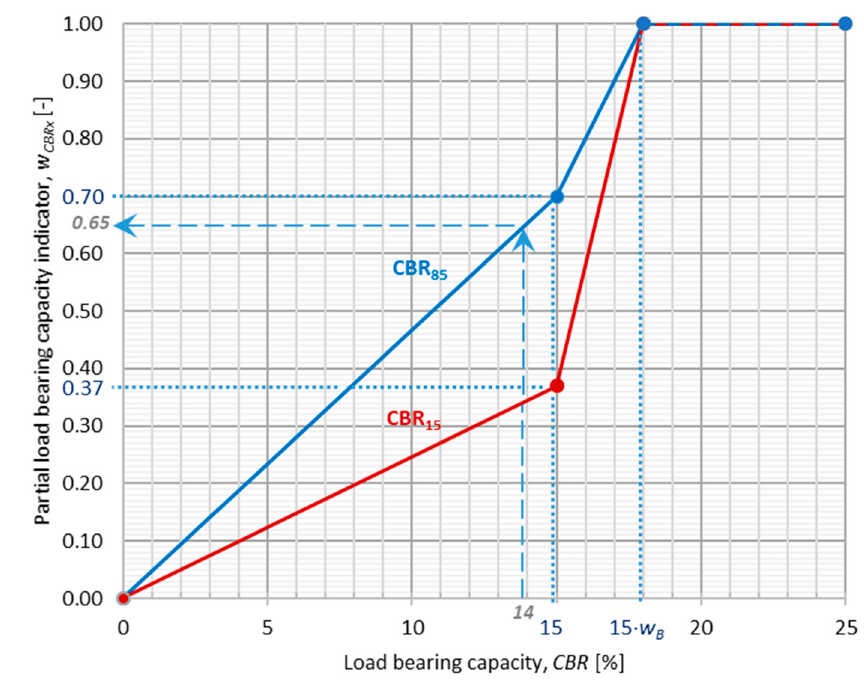
Figure 10. Nomogram for reading partial load bearing capacity indices of natural airfield pavements: CBR 15 —curve for the intermediate layer 0–15 cm, CBR 85 —curve for the intermediate layer 15–85 cm, w B —safety factor (w B = 1.2).